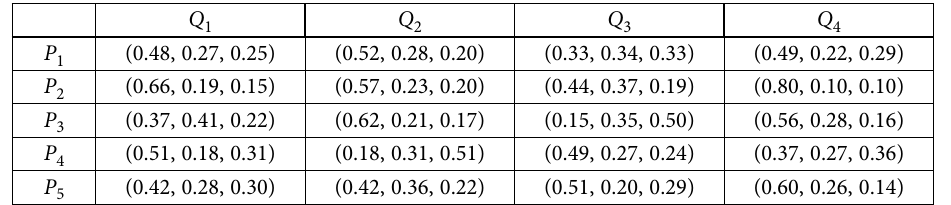
Table 3. Picture fuzzy evaluation information by DM